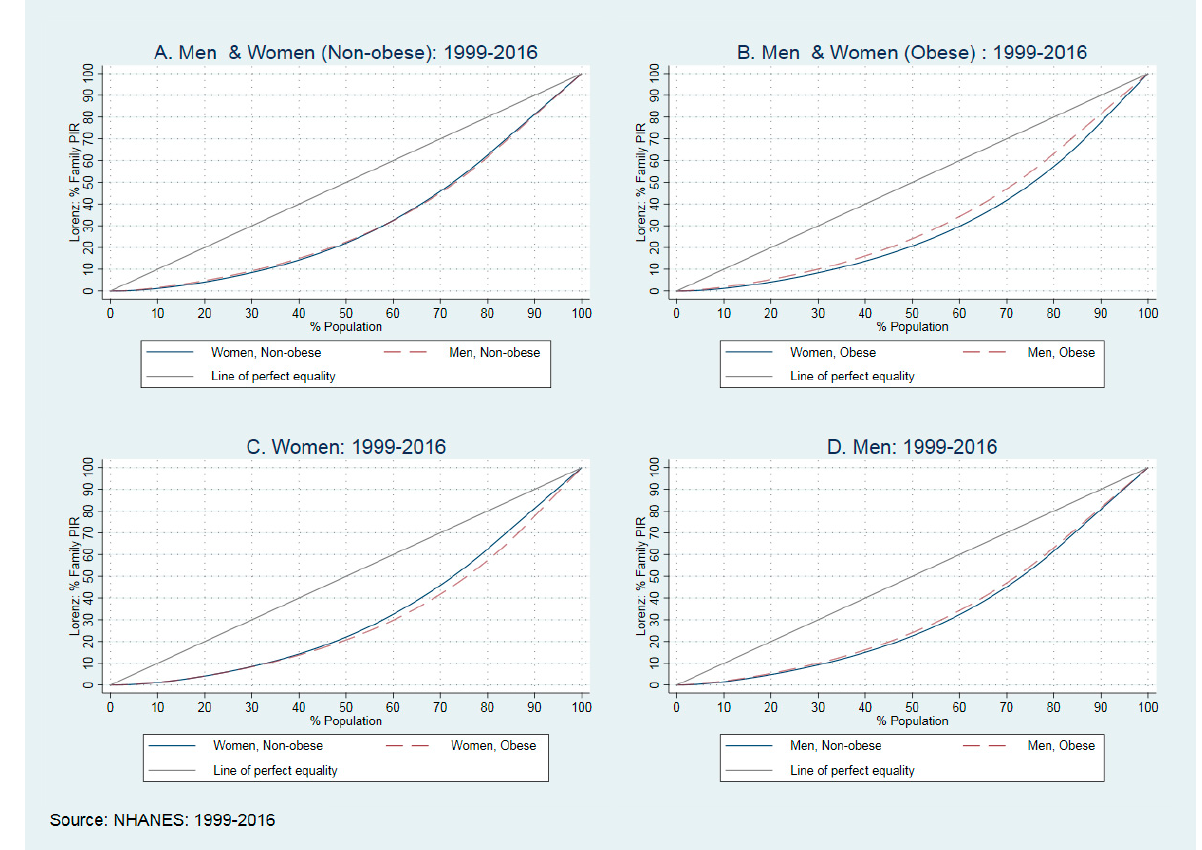
Figure 2. The Lorenz curves and Gini coefficients in men and women between 1999–2016. In panels C and D, we compare the GC between the populations of obese and non- obese men and women. As presented, obese women between the 5th and 10th percentile of the population suffered more from income inequality (panel C); the GC in obese women moved between 0.337 (SE: 0.003) to 0.351 (0.002) in non-obese women. For men, there is higher income inequality in the non-obese population (panel D). The red-dashed line that represents obese-men stays above the solid blue line (non-obese men), meaning lower income inequities for all income groups. The GC moved from 0.333 (SE: 0.003) in obese men to 0.348 (SE: 0.002) in non-obese